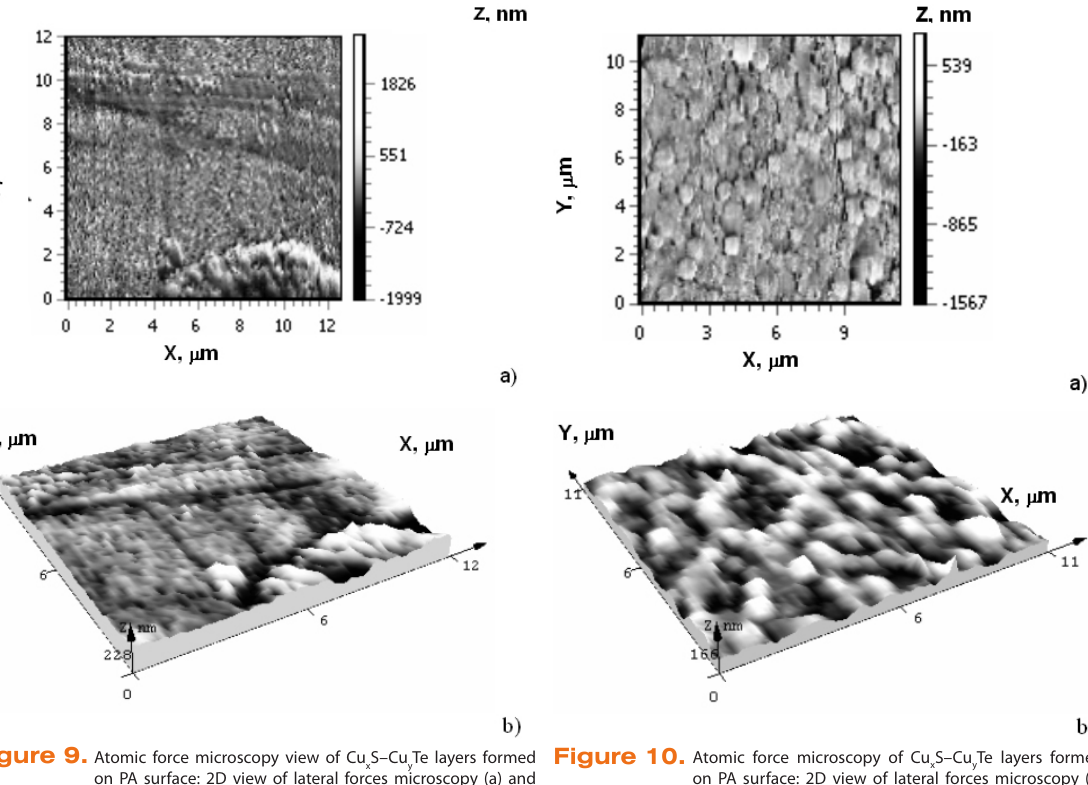
on PA surface: 2D view of lateral forces microscopy (a) and 3D topography view (b). PA was chalcogenized for 24 h at 10 o C in 0.025 mol dm -3 K then treated with Cu(II/I)